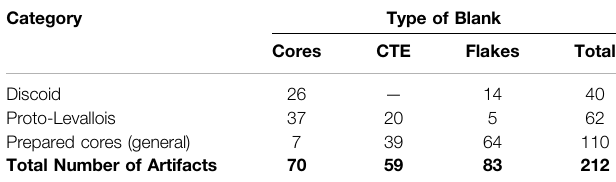
TABLE 1 | The breakdown of the general sample used in this study. TABLE 2 | The PCTs sample from Area